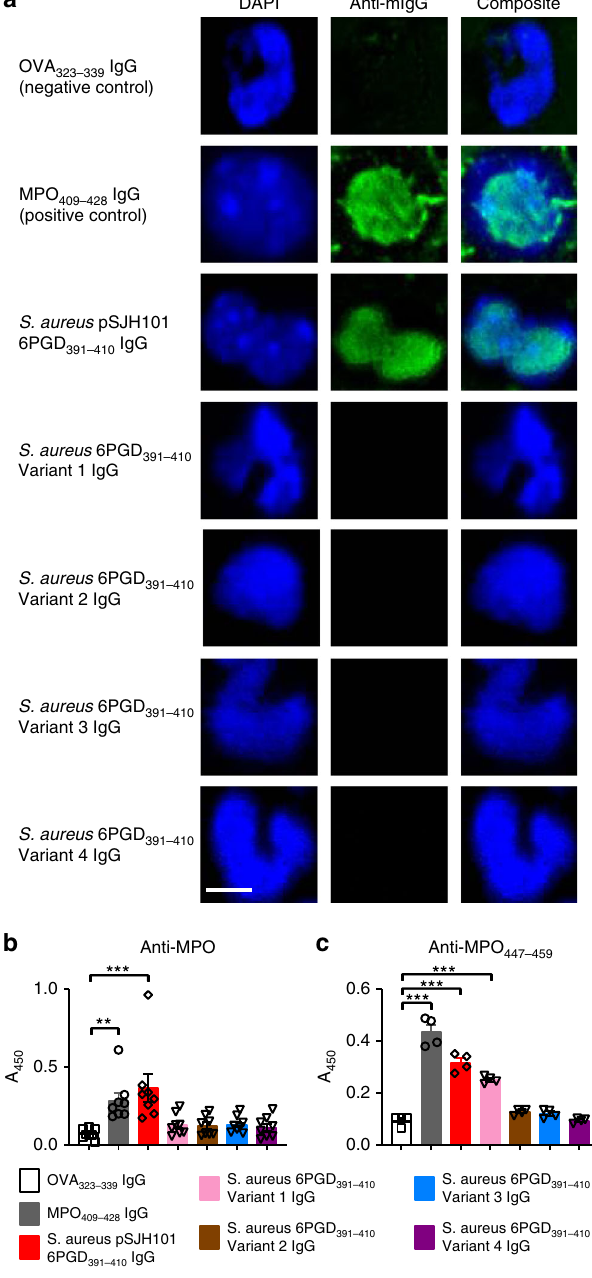
Fig. 6 MPO-ANCA after immunization with S. aureus -derived 6PGD 391 – 410 sequences. a Perinuclear (pANCA) detection using puri fi ed serum IgG, pooled from each group of C57BL/6 mice ( n = 8 each group) immunized with OVA 323 – 339 , MPO 409 – 428 , pSJH101-derived 6PGD 391 – 410 (YFKNIVTDYQEALRDVVATG), S. aureus 6PGD 391 – 410 Variant 1 (YFKNIVTDYQDALRDVVATG), S. aureus 6PGD 391 – 410 Variant 2 (YFKNIVTNYQEALRDVVATG), S. aureus 6PGD 391 – 410 Variant 3 (YFKNIVTEYQDALRDVVATG), S. aureus 6PGD 391 – 410 Variant 4 (YFKNIVTNYQDALRDVVATG) (amino acid substitutions underlined). Nuclei are blue (DAPI), mouse IgG is green (FITC-conjugated anti-mouse IgG antibody). b Sera from individual mice ( n = 8 each group)